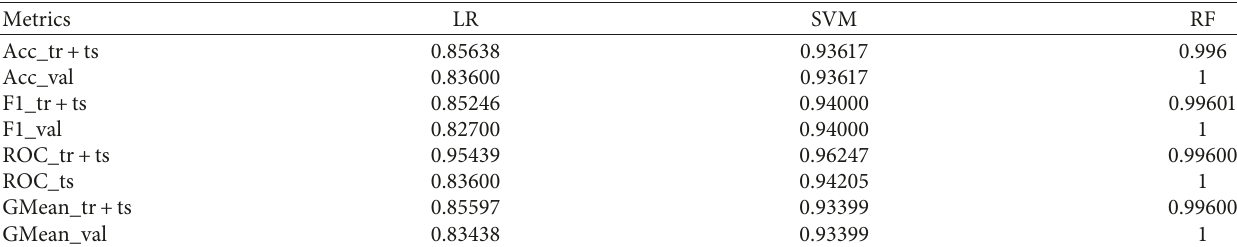
Table 7: For replying interactions from March 12 until April 12 in 2021, utilizing the similarities between nodes, performance of the LR, SVM, and RF models 1